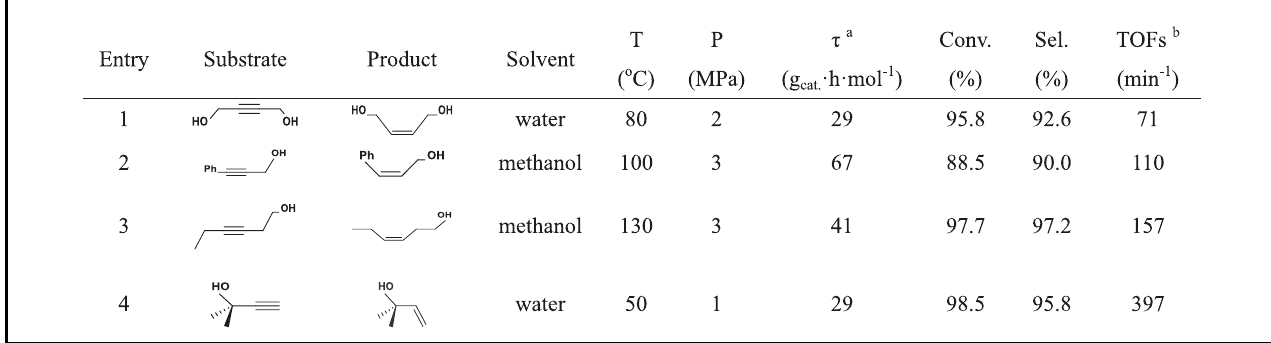
Table 1 The semi-hydrogenation of other industrially relevant alkynols over Pd/ZnO-400 catalyst.